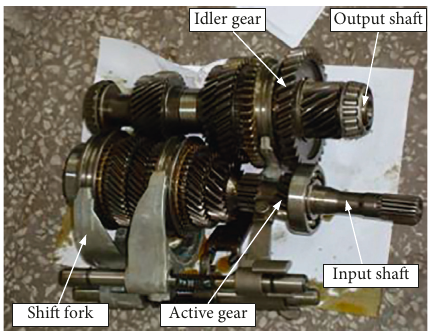
Figure 1: The typical structure of automotive (1) The rattle effects between gear teeth finish in a short